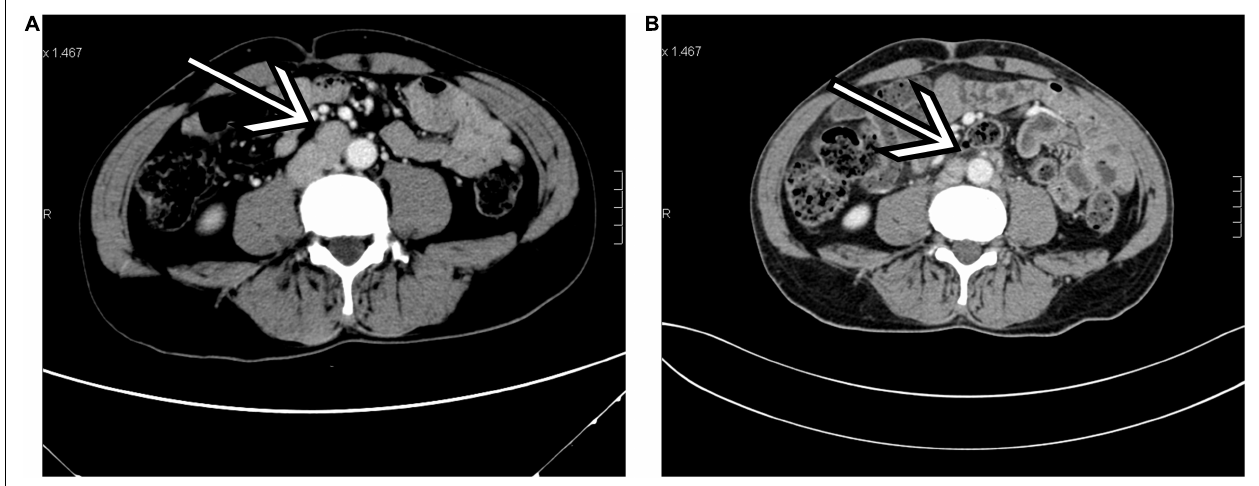
FIGURE 1 | A 50-year-old man with Sertoli cell tumors (SCT; case 10). (A) Transverse contrast-enhanced CT (arterial phase) performed before orchiectomy showed enlarged para-aortic lymph nodes (arrow). (B) The same level of contrast-enhanced CT (arterial phase) performed 40 months after orchiectomy found that the enlarged para-aortic lymph nodes had diminished (arrow). ** p < 0.01, *** p < 0.001.